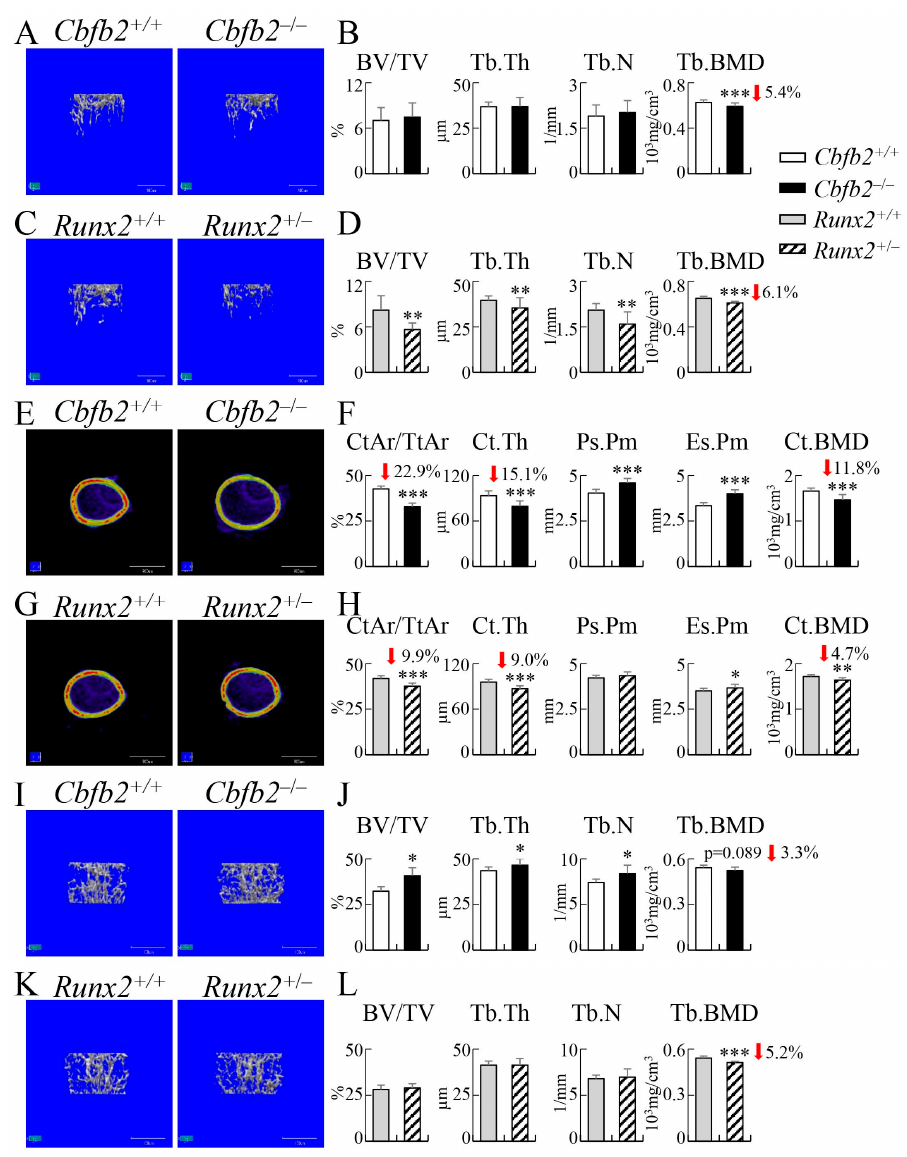
Figure 10. Micro ‐ CT analyses of femurs and lumbar vertebrae in male mice at 4 weeks of age. ( A – D ) Three ‐ dimensional trabecular bone architecture of distal femoral metaphysis ( A , C ) and quantification of the trabecular bone volume (bone volume/tissue volume, BV/TV), trabecular thickness (Tb.Th), trabecular number (Tb.N) and trabecular bone mineral density (Tb.BMD) in Cbfb2 +/+ and Cbfb2 –/– mice ( B ) and Runx2 +/+ and Runx2 +/– mice ( D ). ( E – H ) Micro ‐ CT images of cortical bone at mid ‐ diaphysis in femurs ( E , G ) and quantification of the cortical area (CtAr/TtAr), cortical thickness (Ct.Th), periosteal perimeter (Ps.Pm), endosteal perimeter (Es.Pm) and cortical bone mineral density (Ct.BMD) in Cbfb2 +/+ and Cbfb2 –/– mice ( F ) and Runx2 +/+ and Runx2 +/– mice ( H ). The number of mice analyzed: Cbfb2 +/+ , n = 22; Cbfb2 –/– , n = 14; Runx2 +/+ , n = 11; Runx2 +/– , n = 8. ( I – L ) Three ‐ dimensional trabecular bone architecture of 1st lumbar vertebrae ( I , K ) and trabecular bone parameters in Cbfb2 +/+ and Cbfb2 –/– mice ( J ) and Runx2 +/+ and Runx2 +/– mice ( L ). Scale bars: 1 mm. Data are shown as the mean ± SD. * p < 0.05, ** p < 0.01 and *** p < 0.001. The number of mice analyzed: Cbfb2 +/+ , n = 9; Cbfb2 – /– , n = 7; Runx2 +/+ , n = 11; Runx2 +/– , n = 8.